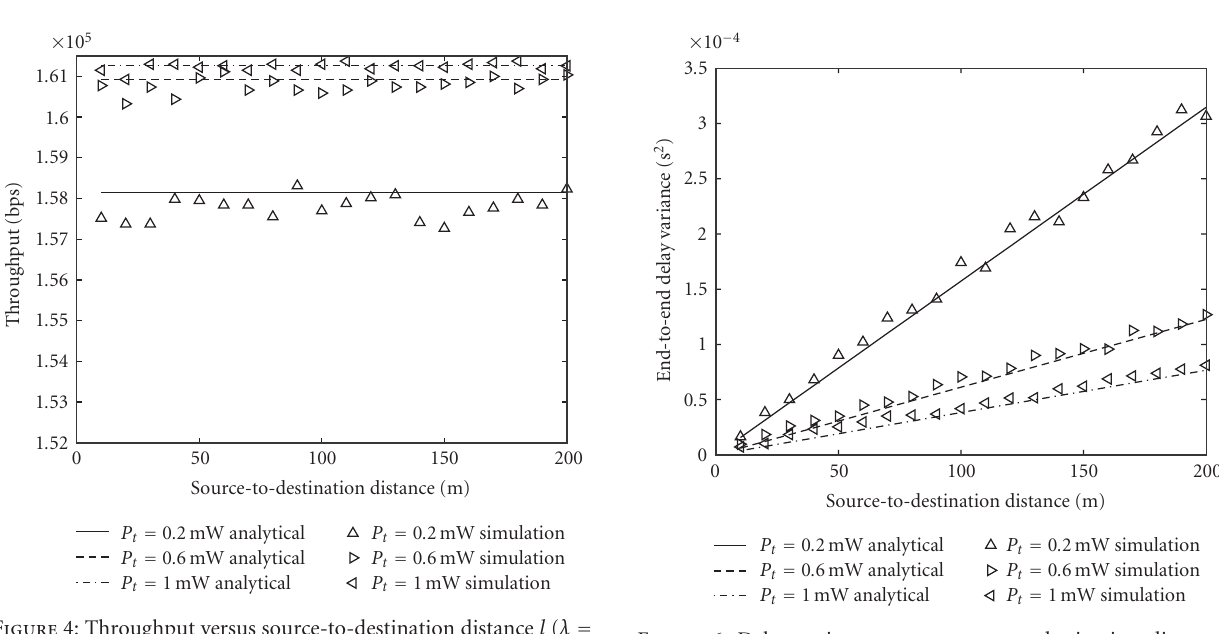
Figure 6: Delay variance versus source-to-destination distance l ( λ = 0 . 1 / m 2 ).